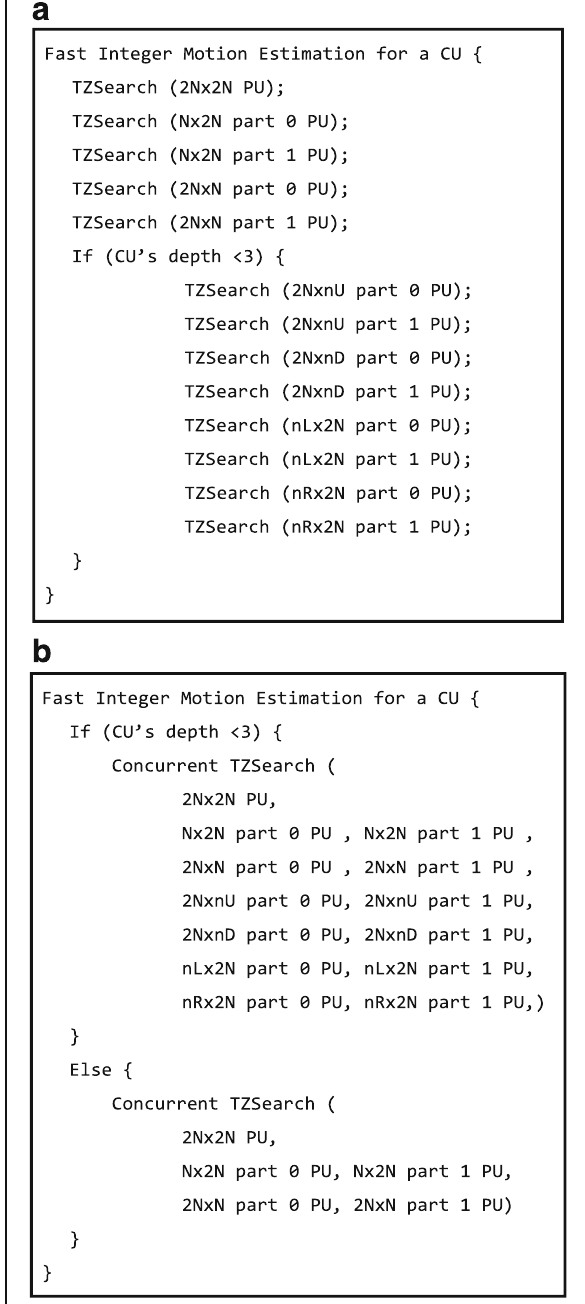
Fig. 2 The pseudocode of the fast integer motion estimation process. a Original TZ search algorithm. b Hardware-oriented concurrent TZ search